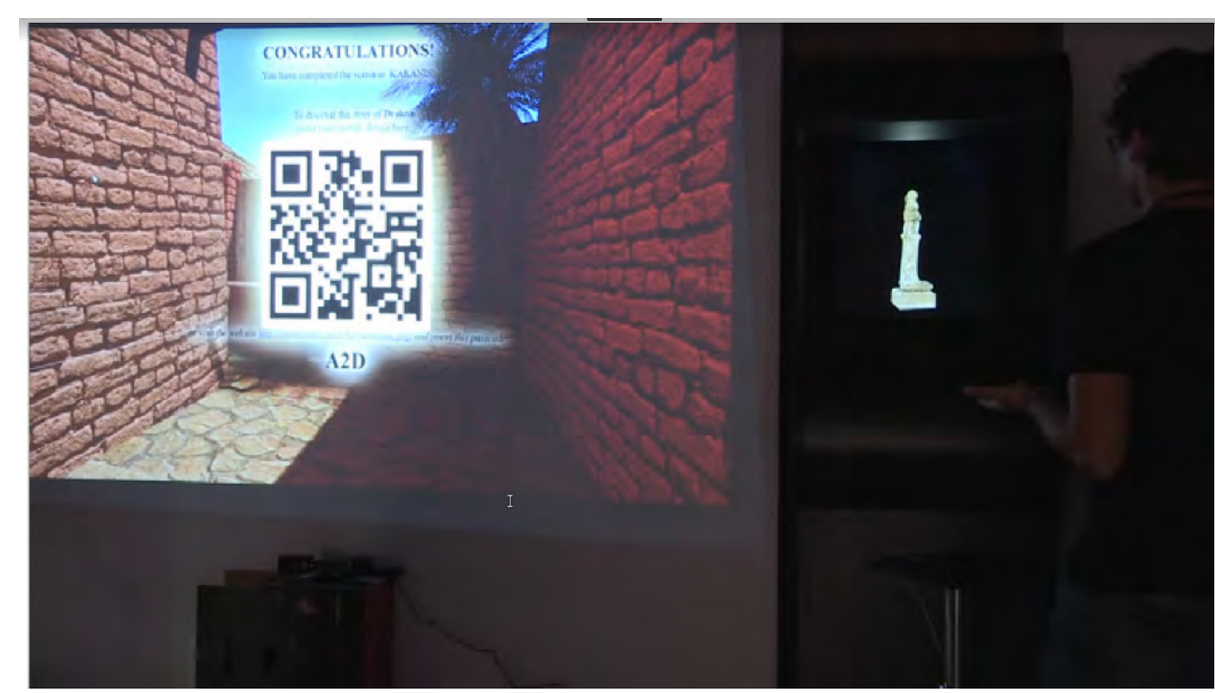
Figure 2. Holobox setup